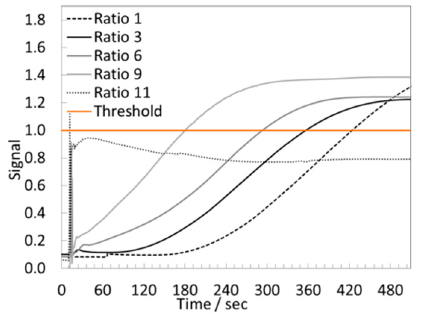
Figure 7. Experimental results for ratio determination of aggregation of AuNP solutions, run-time = 8.5 min. (a) 2-LED-µSpectrophotometer absorbance ratio of selected dilutions: 1 = 100%, 3 = 80%, 6 = 50%, 9 = 20%, and 11 = water.